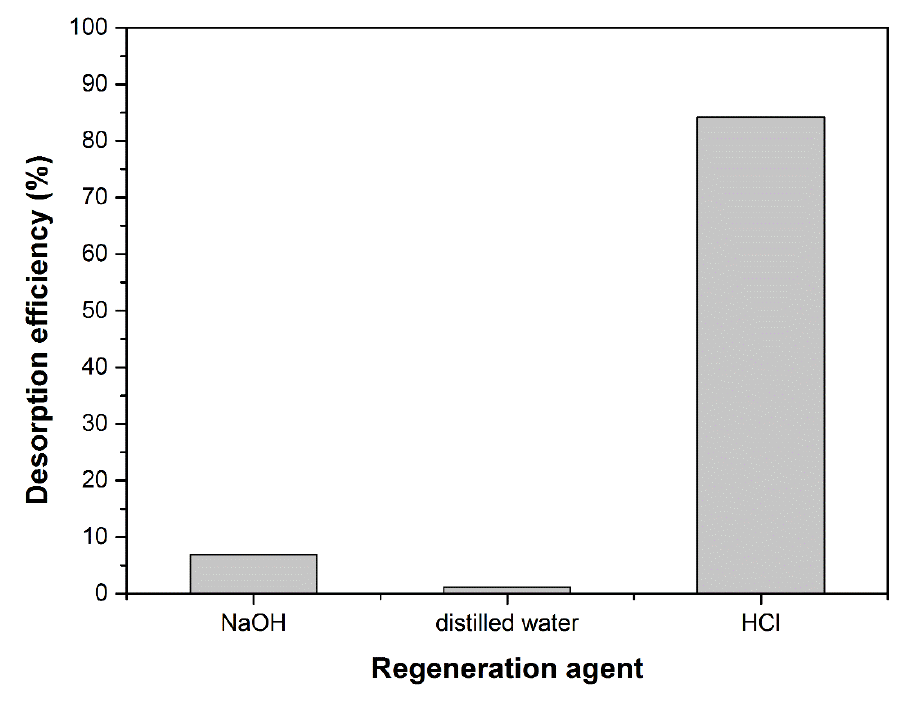
Figure 9. The desorption efficiency in three different media.